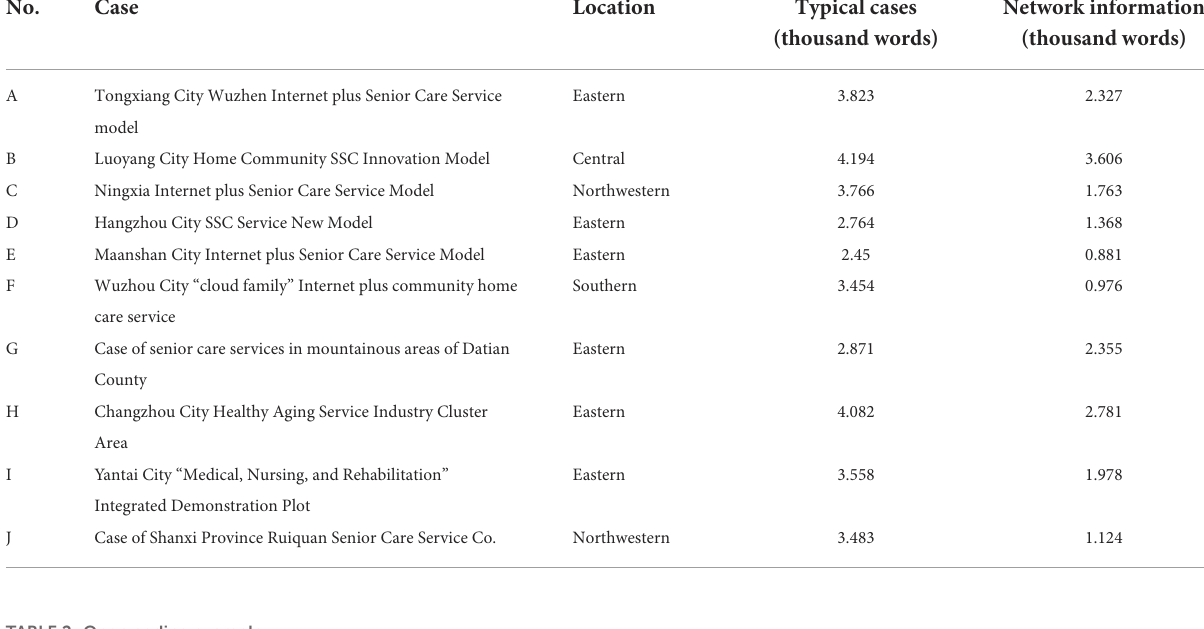
TABLE 1 Source type and text statistics.